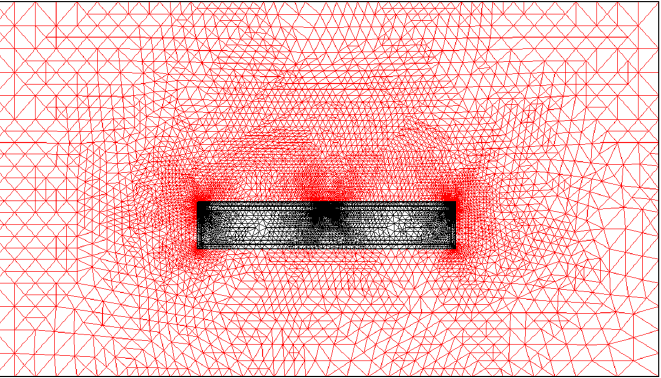
Figure 5. Typical mesh generated in simulated water conditions. Increased mesh density is observed to be generated between the transmitter and receiver electrodes and on the region that corresponds to the edge of the electrodes.